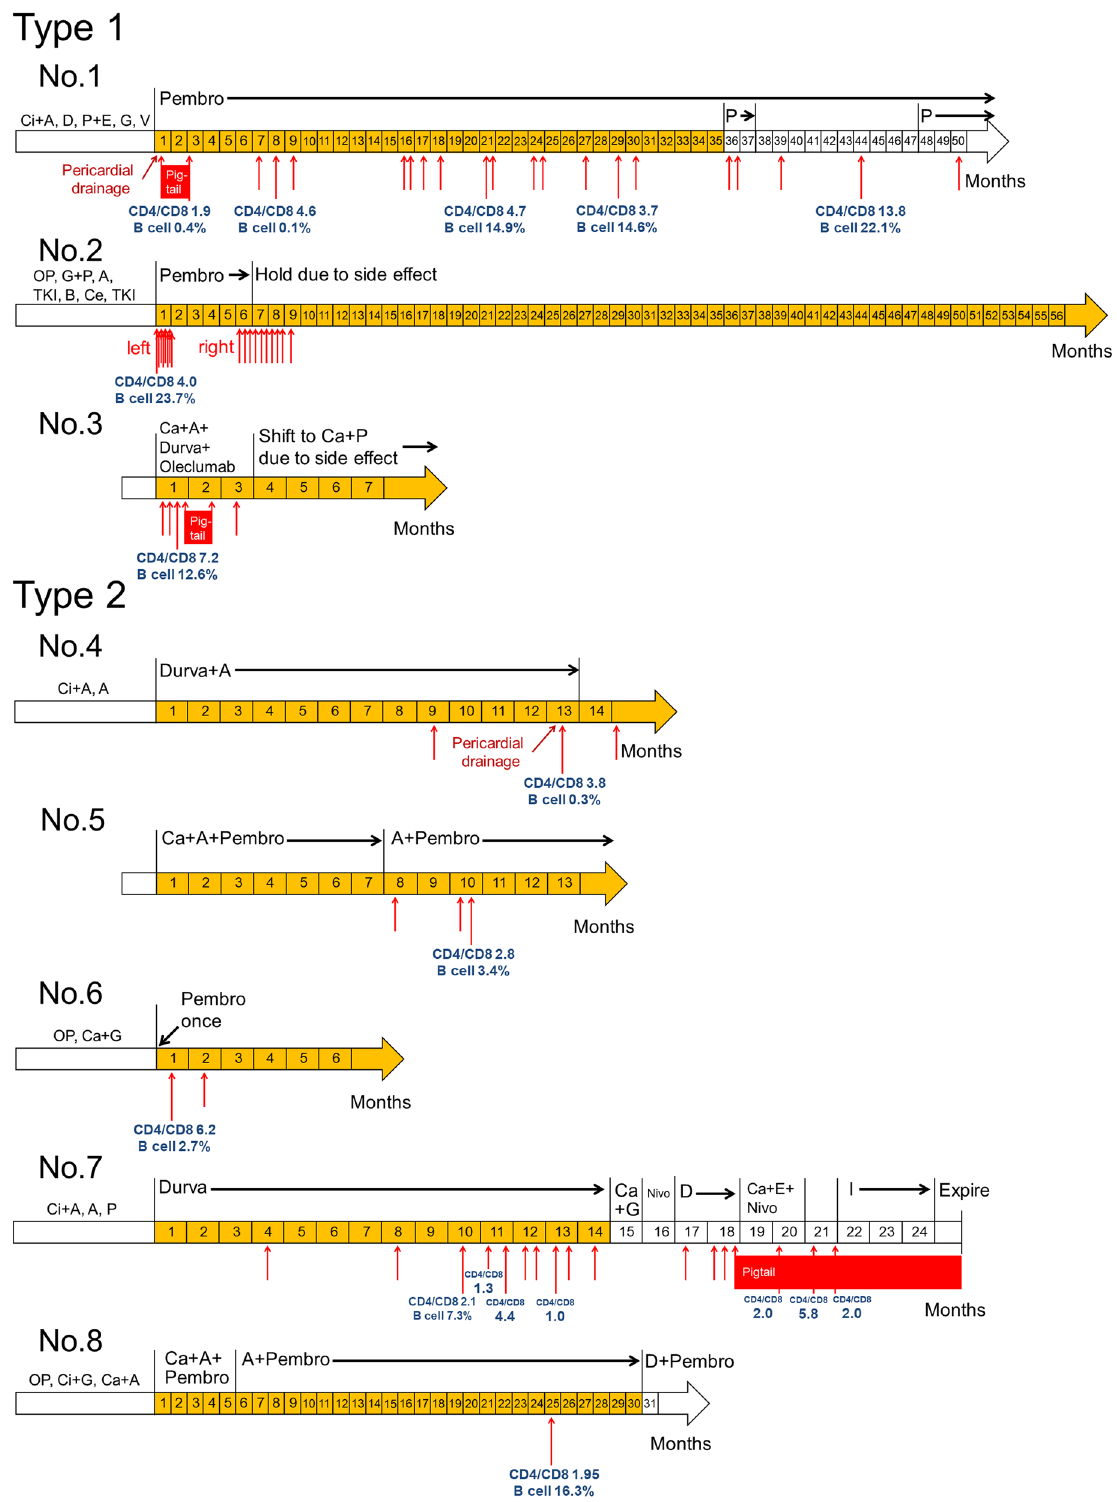
Figure 2. Disease course and treatment timeline for patients with type 1 and type 2 pleural effusions. Red Arrow: Pleural effusion requiring thoracentesis. Time line highlighted in yellow: progression free survival (the number within the timeline indicates the month after the immune checkpoint inhibitor (ICI) initiation). The left side of the yellow bar refers to the initiation of the ICI. The regimens of each patient were listed above the timeline. Ci, cisplatin; A, pemetrexed (Alimta); D, docetaxel; P, paclitaxel; E, etoposide; G, gemcitabine; V, vinorelbine; Pembro, pembrolizumb; OP, surgical intervention; TKI, EGFR -tyrosine kinase inhibitor; B, bevacizumab; Ce, cetuximab; Ca, carboplatin; Durva, durvalumab; Nivo, nivolumab; I,